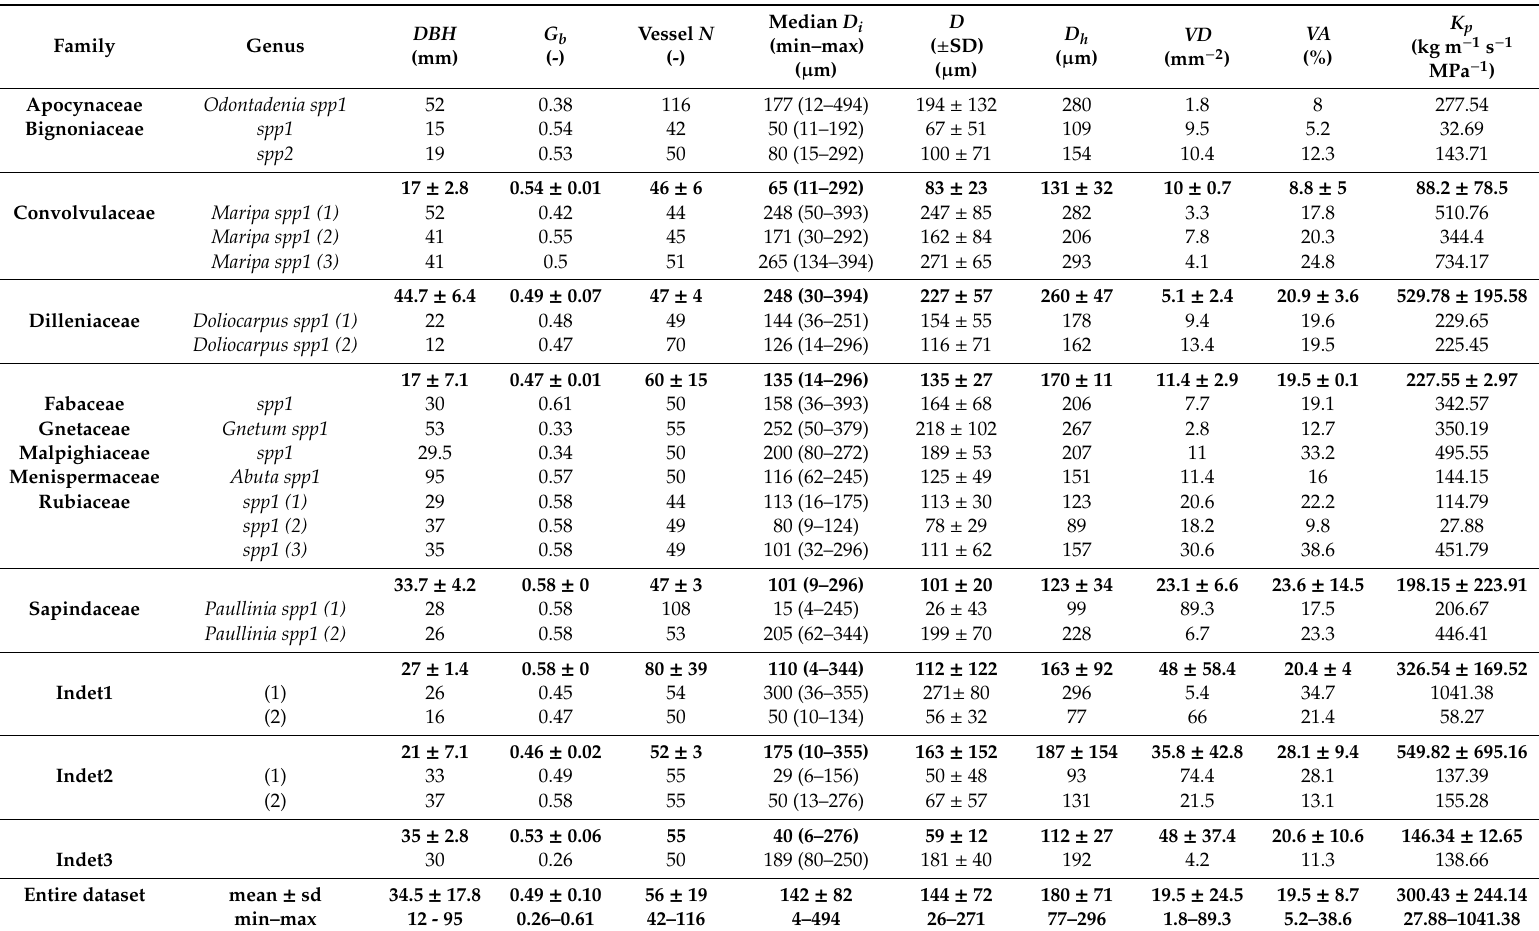
Table 1. Wood anatomical, structural, and hydraulic properties of the 22 liana individuals, alongside with the family and whole dataset aggregated values (bold). The numbers in parentheses are subjective identifiers which distinguish individuals from the same morpho-species. DBH = diameter at breast height, G b = basic specific gravity, N = number of measured vessels, D i = vessel diameter, D = mean vessel diameter, D h = hydraulically weighted mean diameter, VD = vessel density, VA = vessel area fraction, K p = maximum stem